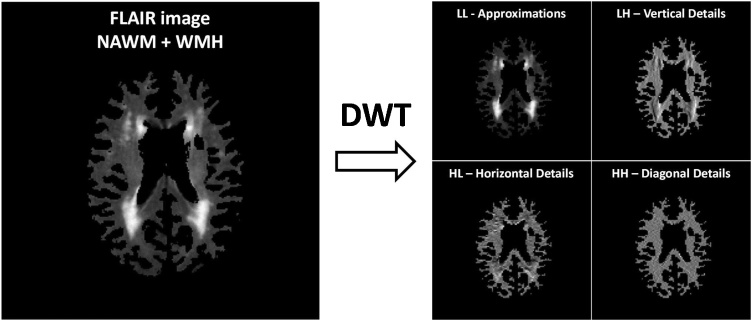
First DWT level of decomposition of a FLAIR image of the white matter tissue (NAWM and WMH) of a single brain slice.